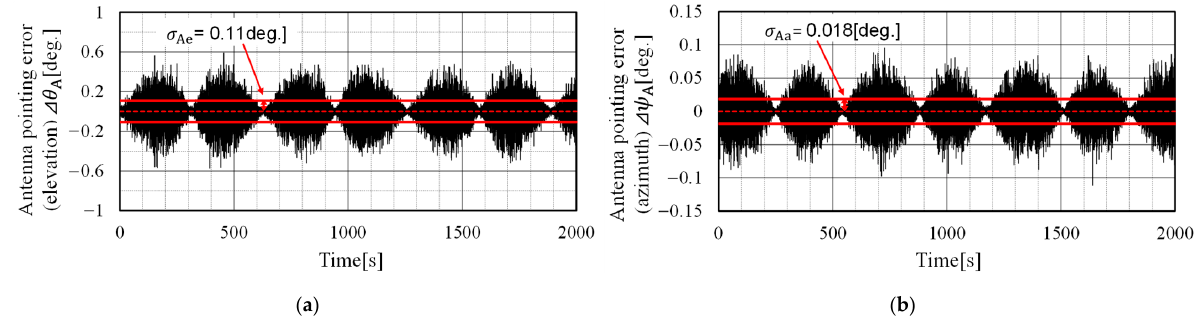
Figure 24. Time history of the antenna’s pointing control errors using RF sensor with 0.05 deg. ac-